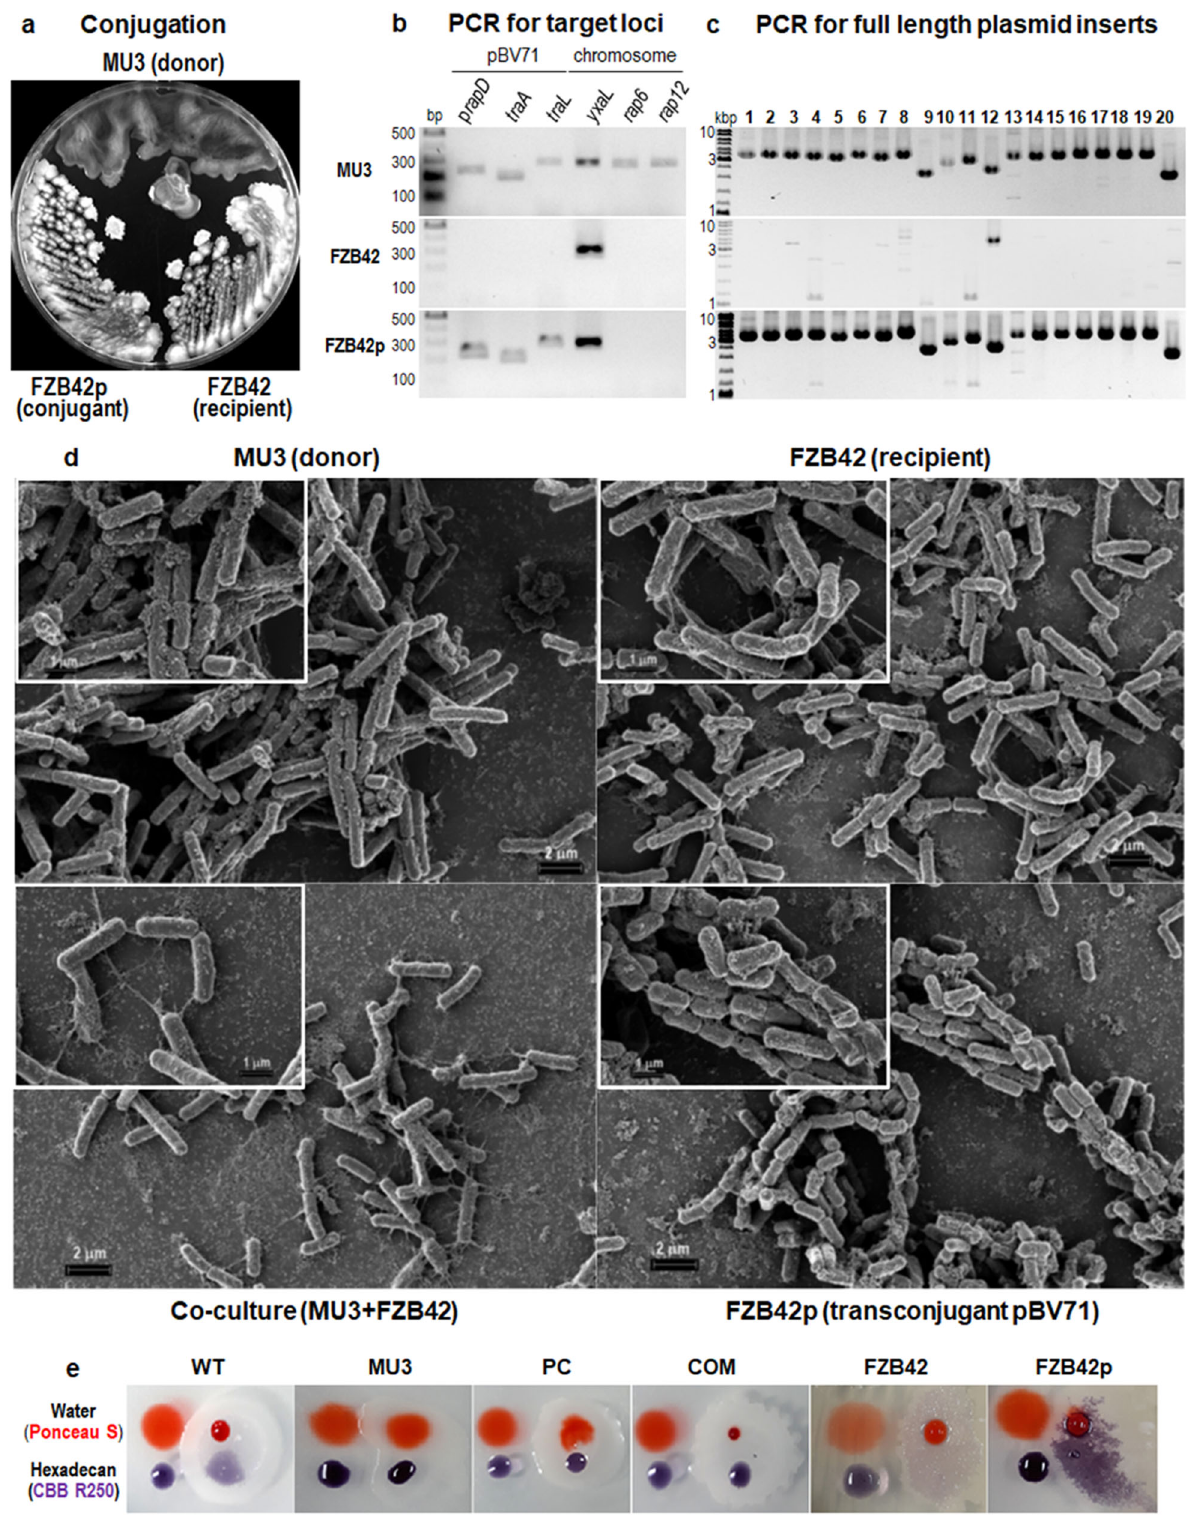
Fig. 4 Conjugation of pBV71 into strain FZB42 from a mucoid variant (MU3) of strain GH1-13. a Morphologies of MU3 (donor), FZB42 (recipient), and a transconjugant FZB42p with pBV71 on R2A plate. b , c PCR results for WT, MU3, and COM cells using plasmid and chromosome-speci fi c primer pairs ( b ) and plasmid genome primer sets ( c ) as described in the Methods section. d Scanning electron microscopy (AURIGA) images of platinum-coated MU3 (donor), FZB42 (recipient), co-culture of donor and recipient, and a transconjugant FZB42p. Cells were pre-cultivated on a silicon wafer with TSB medium at 37 °C and fi xed cell images were captured at 10,000-fold magni fi cation and 30,000-fold magni fi cation (insets). e Hydrophobicity tests for colony surfaces of WT, MU3, PC, COM, FZB42, and FZB42p cells grown on R2A plates. Hydrophobicity was detected on colony surfaces by the degree of absorption of 5 µ L drops of water and hexadecane containing Ponceau S and Coomassie Brilliant Blue (CBB) R250 indicator